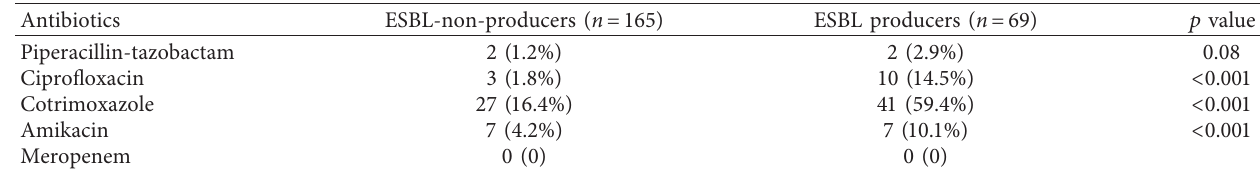
Table 6: Antimicrobial resistance rates of ESBL-producing and non-producing